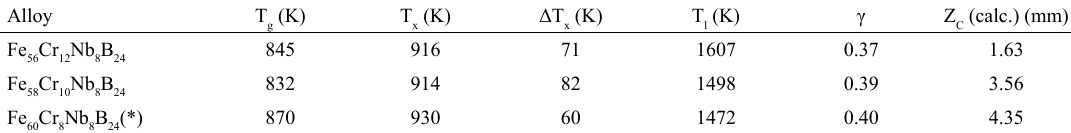
) and crystallization temperature g ). l ). C